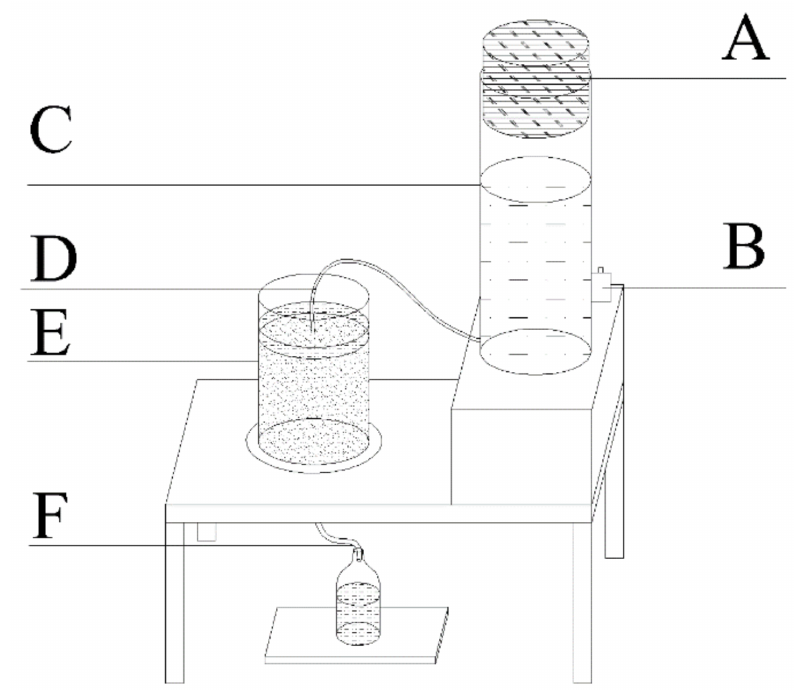
Figure 1. Diagram of the experiment setup. ( A ), Rubber plug; ( B ), air inlet; ( C ), Markov bottle; ( D ), water inlet; ( E ), soil column of text and ( F ), water